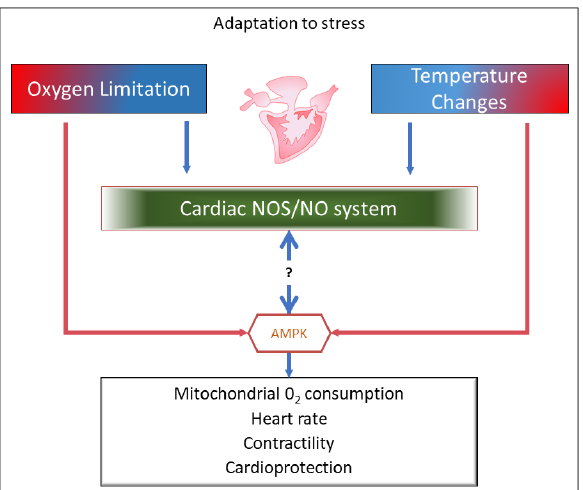
Figure 1. Graphical representation of the review content. Under conditions of O 2 limitations and temperature variations, the nitric oxide synthase (NOS)/nitric oxide (NO) system, by directly or indirectly interacting with critical kinases, e.g., AMP-activated protein kinase (AMPK), modulates molecular mechanisms that in the fish heart sustain stress tolerance and adaptation.